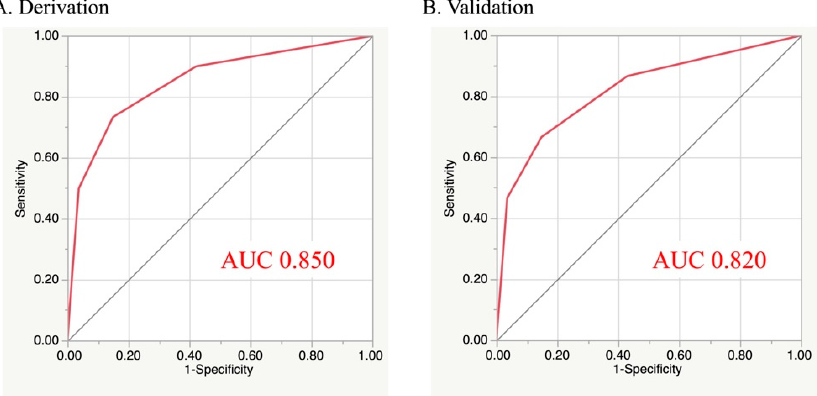
Figure 2. Post-discharge death rates according to the risk-score estimated by the laboratory model.